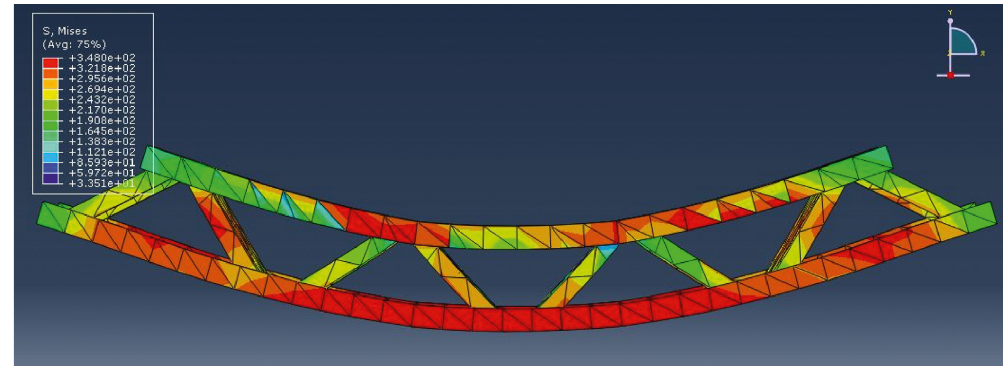
Figure 11: von Mises stress of embedded steel truss.